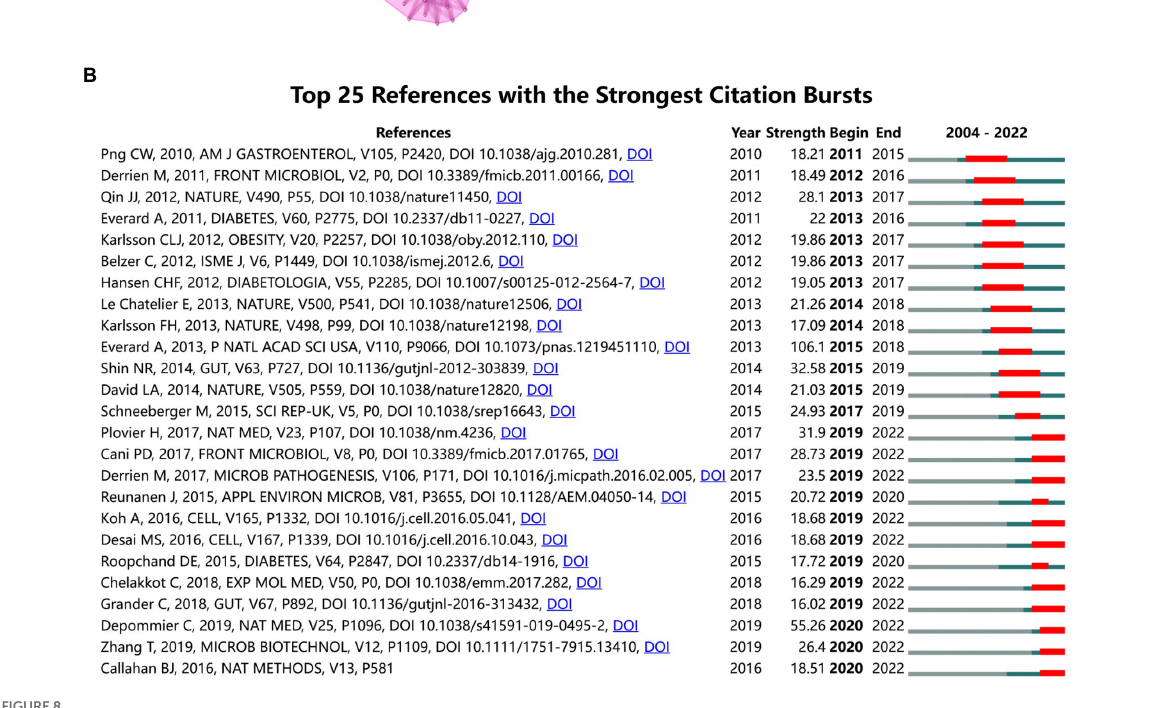
FIGURE 8 Analysis of references in A. muciniphila research. (A) The network map of co-cited references. Each node represents a different reference. The cited references form several natural clusters, which are closely related. The purple outer circle highlights nodes with intermediary centrality greater than 0.1. (B) Top 25 A. muciniphila -related references with the strongest citation bursts